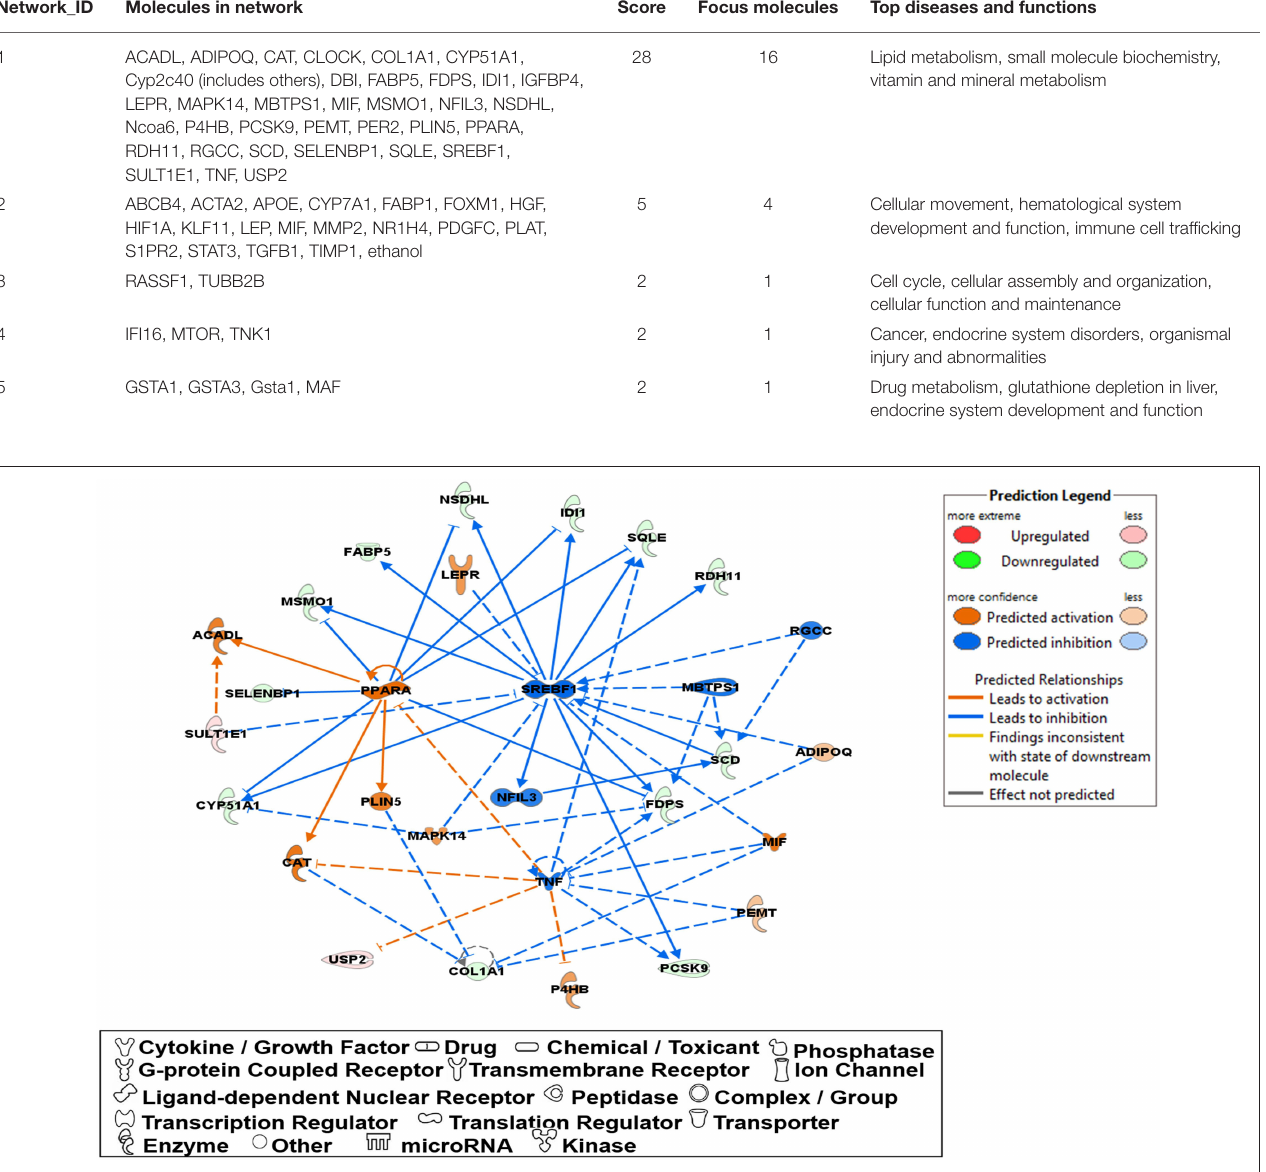
FIGURE 5 | A network relevant to “lipid metabolism”, “small molecule biochemistry”, “vitamin and mineral represented in a gene network (network ID 1). Red, green, orange, and blue represent upregulation and downregulation, and predicted upregulation and downregulation, respectively.